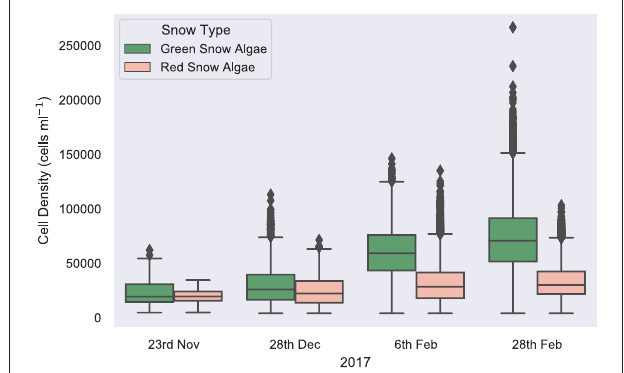
FIGURE 10 | Remotely sensed cell density. A boxplot showing the change in average snow algal cell density for Anchorage Island, recorded by WorldView 2 and 3 imagery, through a growing